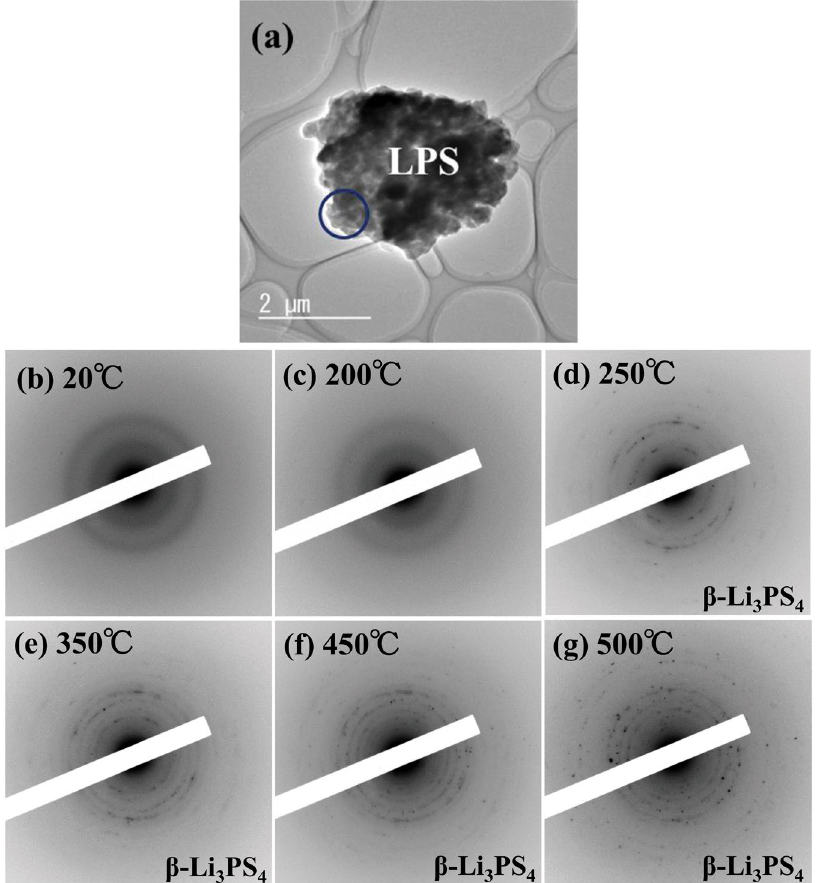
Figure 6. ( a ) The BF image indicating the morphology of the LPS glass without interfacial contact with NMC. ( b–g ) A series of ED patterns obtained from the area indicated by the blue circle in ( a ) upon heating from 20 °C to 500